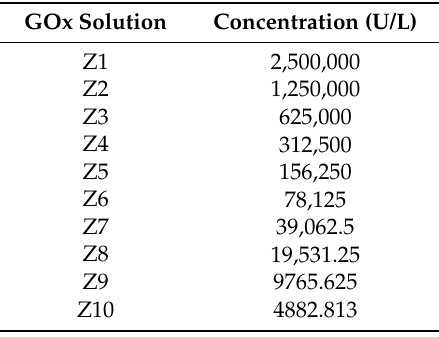
Table 1. Concentration of glucose oxidase (Gox) enzyme solution.